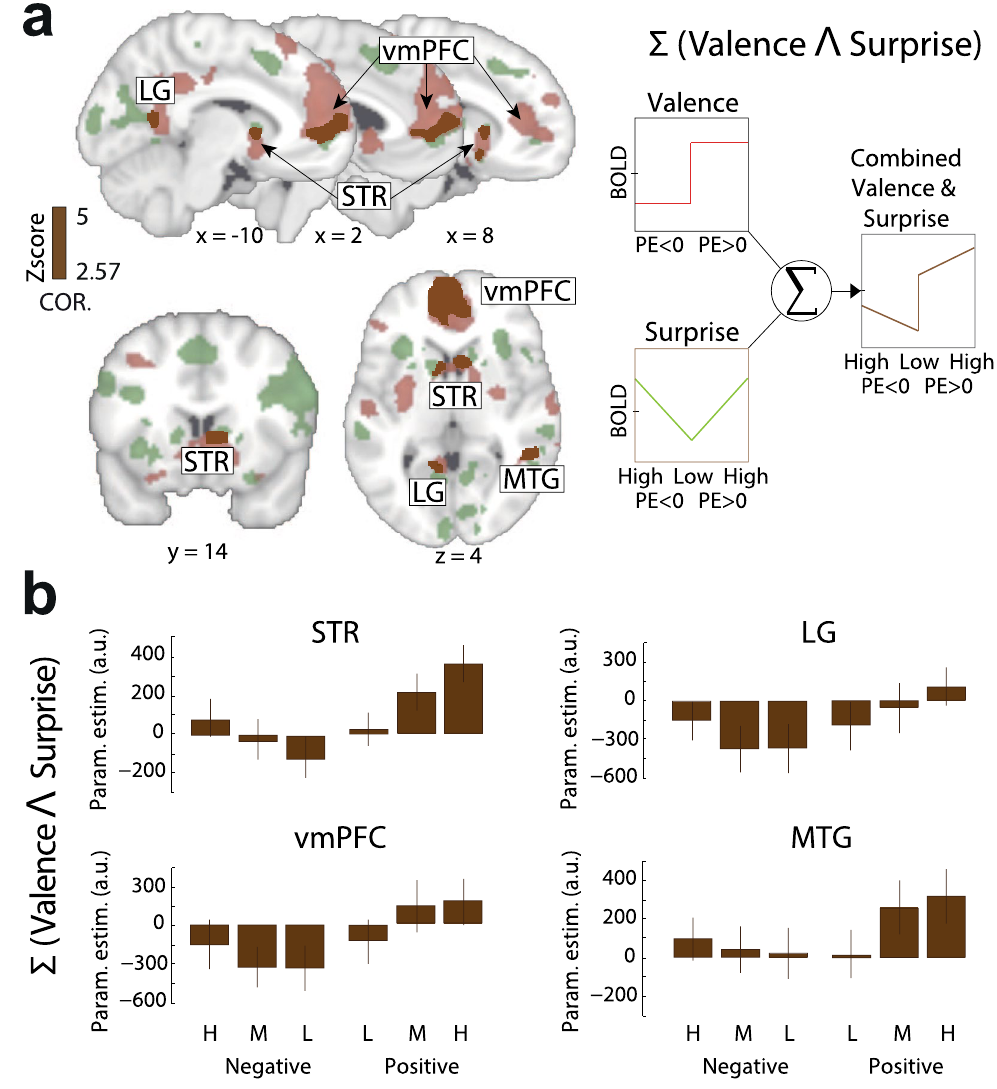
Figure 5. Full spatial representation of the RPE valence and surprise networks and their overlap. ( a ) A conjunction analysis on the results arising from the EEG-informed regressors for the RPE valence (red clusters) and surprise (green clusters) components revealed that four areas – the STR, vmPFC, LG and MTG – significantly encoded both quantities (brown clusters). The conjunction analysis was performed using the resulting whole brain activation maps for RPE valence and surprise and applying a Z > 2.57, cluster-corrected ( P < 0.05) using a resampling procedure. ( b ) The four overlapping regions exhibited a clear linear superposition profile between the two RPE components with a higher BOLD signal for positive vs. negative RPEs but also a systematic increase from low (L), to medium (M), to high (H) outcome surprise trials, within each outcome